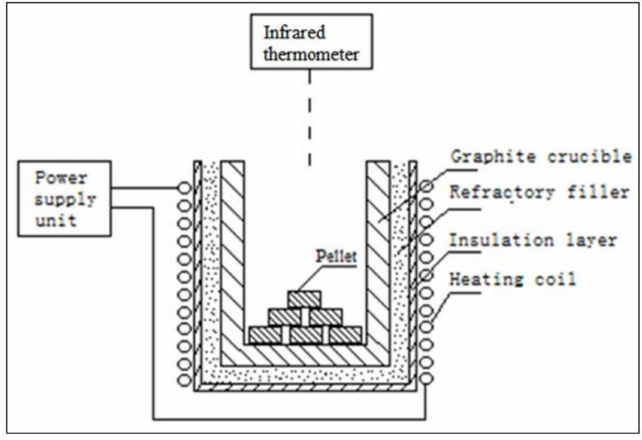
Figure 2. Schematic of high frequency induction